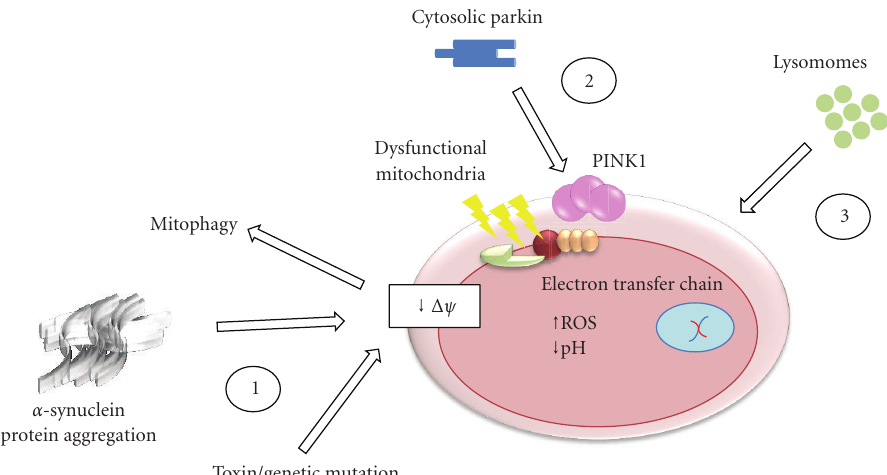
Figure 2: The physiological association of parkin and PINK1 proteins in mitophagy. (1) Genetic mutations or the introduction of toxins lead to various impairments, including depletion of ATP production at the electron transfer chain. A buildup of ROS leads to a more acidic environment within the mitochondrion, as well as inducing a decrease in the mitochondrial transmembrane potential after the opening of permeability transition pores. This is the signal for mitophagy to occur. (2) The process is induced through the interaction of cytosolic parkin with mitochondria-associated PINK1. PINK1 acts as the biochemical signal for parkin to identify damaged mitochondria. (3) Parkin then mediates the lysosomal degradation of the dysfunctional